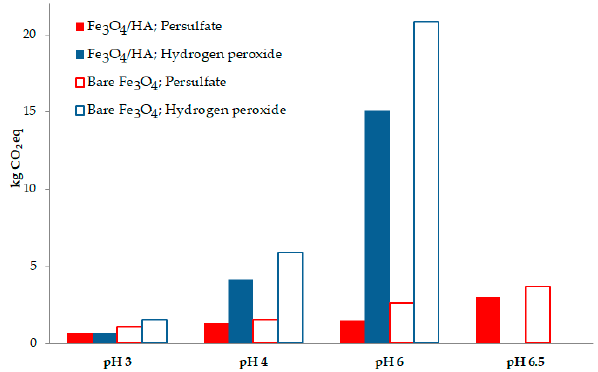
Figure 1. Comparison of the climate change potential (kg CO 2 eq) results of the degradation processes conducted by varying different parameters of pH and oxidants (persulfate and hydrogen peroxide as well as catalyst type Fe 3 O 4 /humic acid (HA) and bare Fe 3 O 4 ).